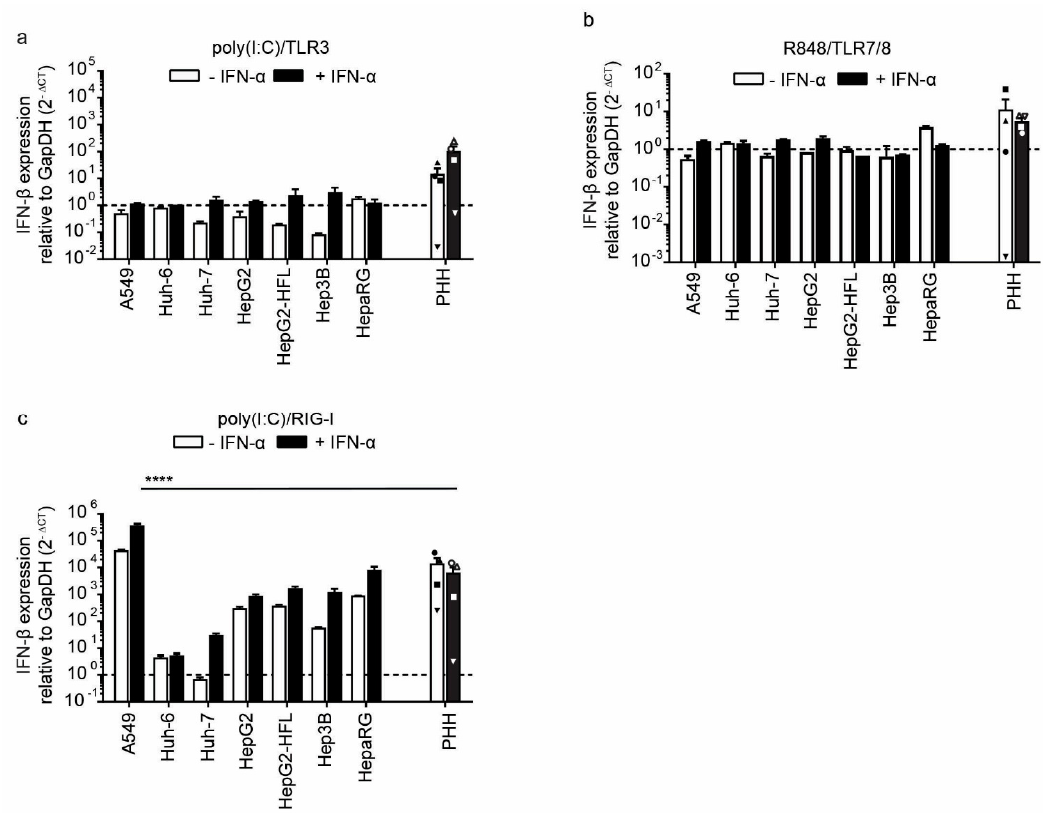
Figure 4. Induction of IFN- β expression after stimulation with indicated agonists of RNA sensors in PHH and hepatoma cells with and without IFN- α pre-stimulation. IFN- β RNA expression in PHHs and hepatoma cell lines mock-treated or pre-treated with IFN- α (100 IU/mL) followed by addition of TLR3 agonist poly(I:C) (1 μ g/mL) ( a ), TLR7/8 agonist R848 (1 μ g/mL) ( b ) or transfected poly(I:C) (2.25 μ g/well) ( c ) as RIG-I agonist. Transcript levels were measured by qRT-PCR 6 h after treatment for cell lines and 24 h after treatment for PHH, as described in Figure 1a. Data for the four different PHH donors are shown as mean ± SEM of single experiments performed in technical duplicates for each donor. For the cell lines, mean ± SEM of one experiment (performed in technical duplicates) is shown. Two-way ANOVA, followed by Dunnett`s multiple comparison test, **** p < 0.0001. Hepatoma cell lines were tested against PHH and only significant comparisons are indicated.